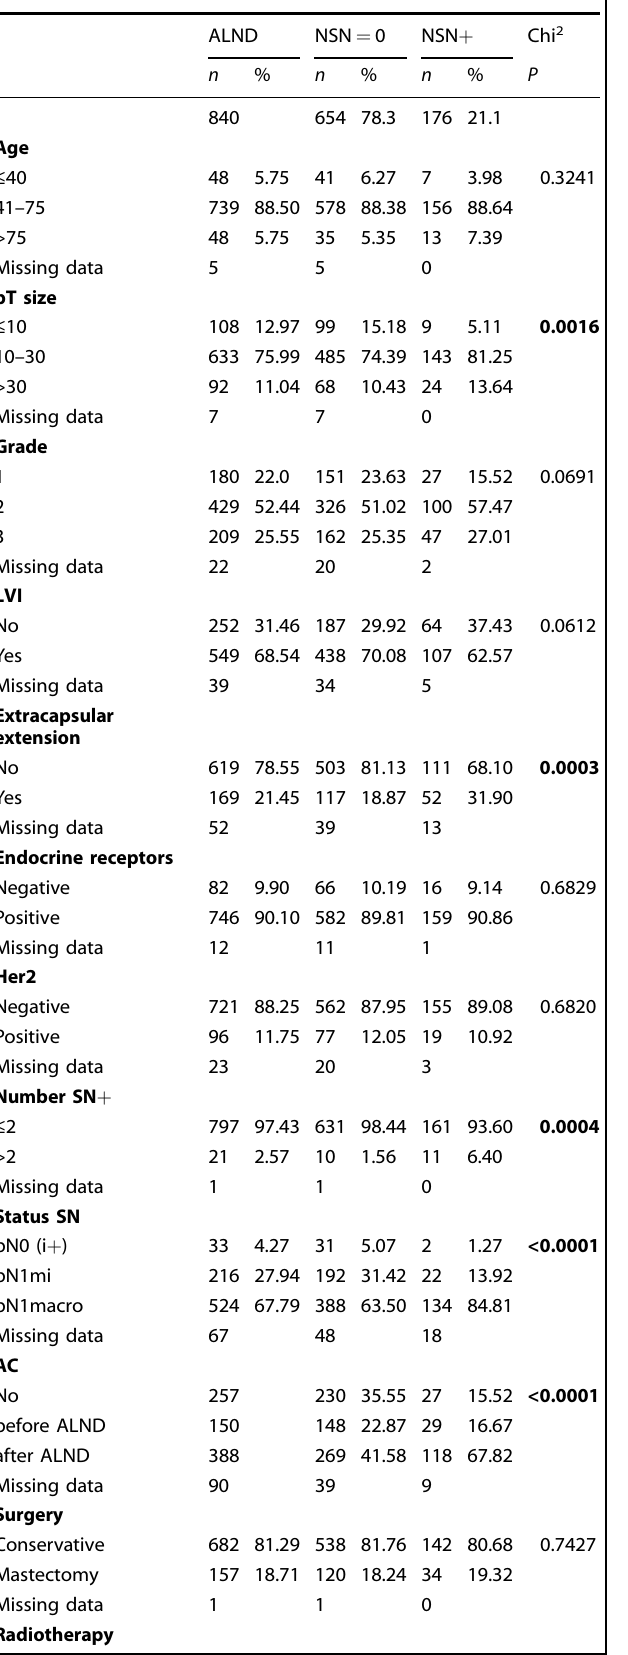
Table 2. Non-sentinel-node involvement rate.